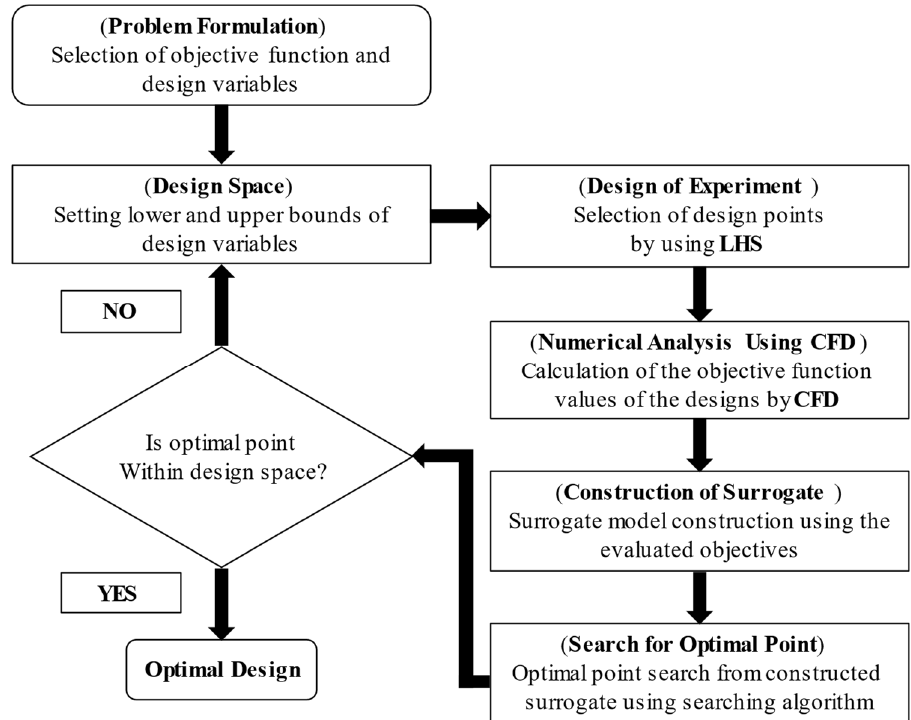
Figure 3. Optimization procedure.